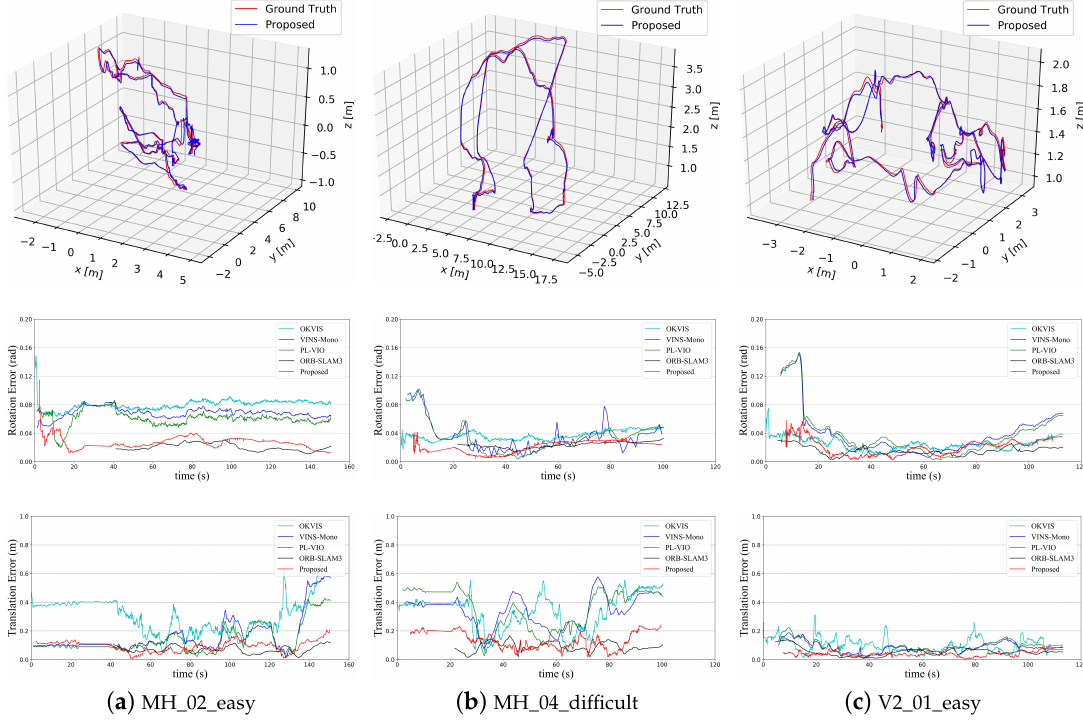
Figure 7. The comparison of the trajectories of our proposed system with the ground truth and the comparison of rotation and the translation errors among all